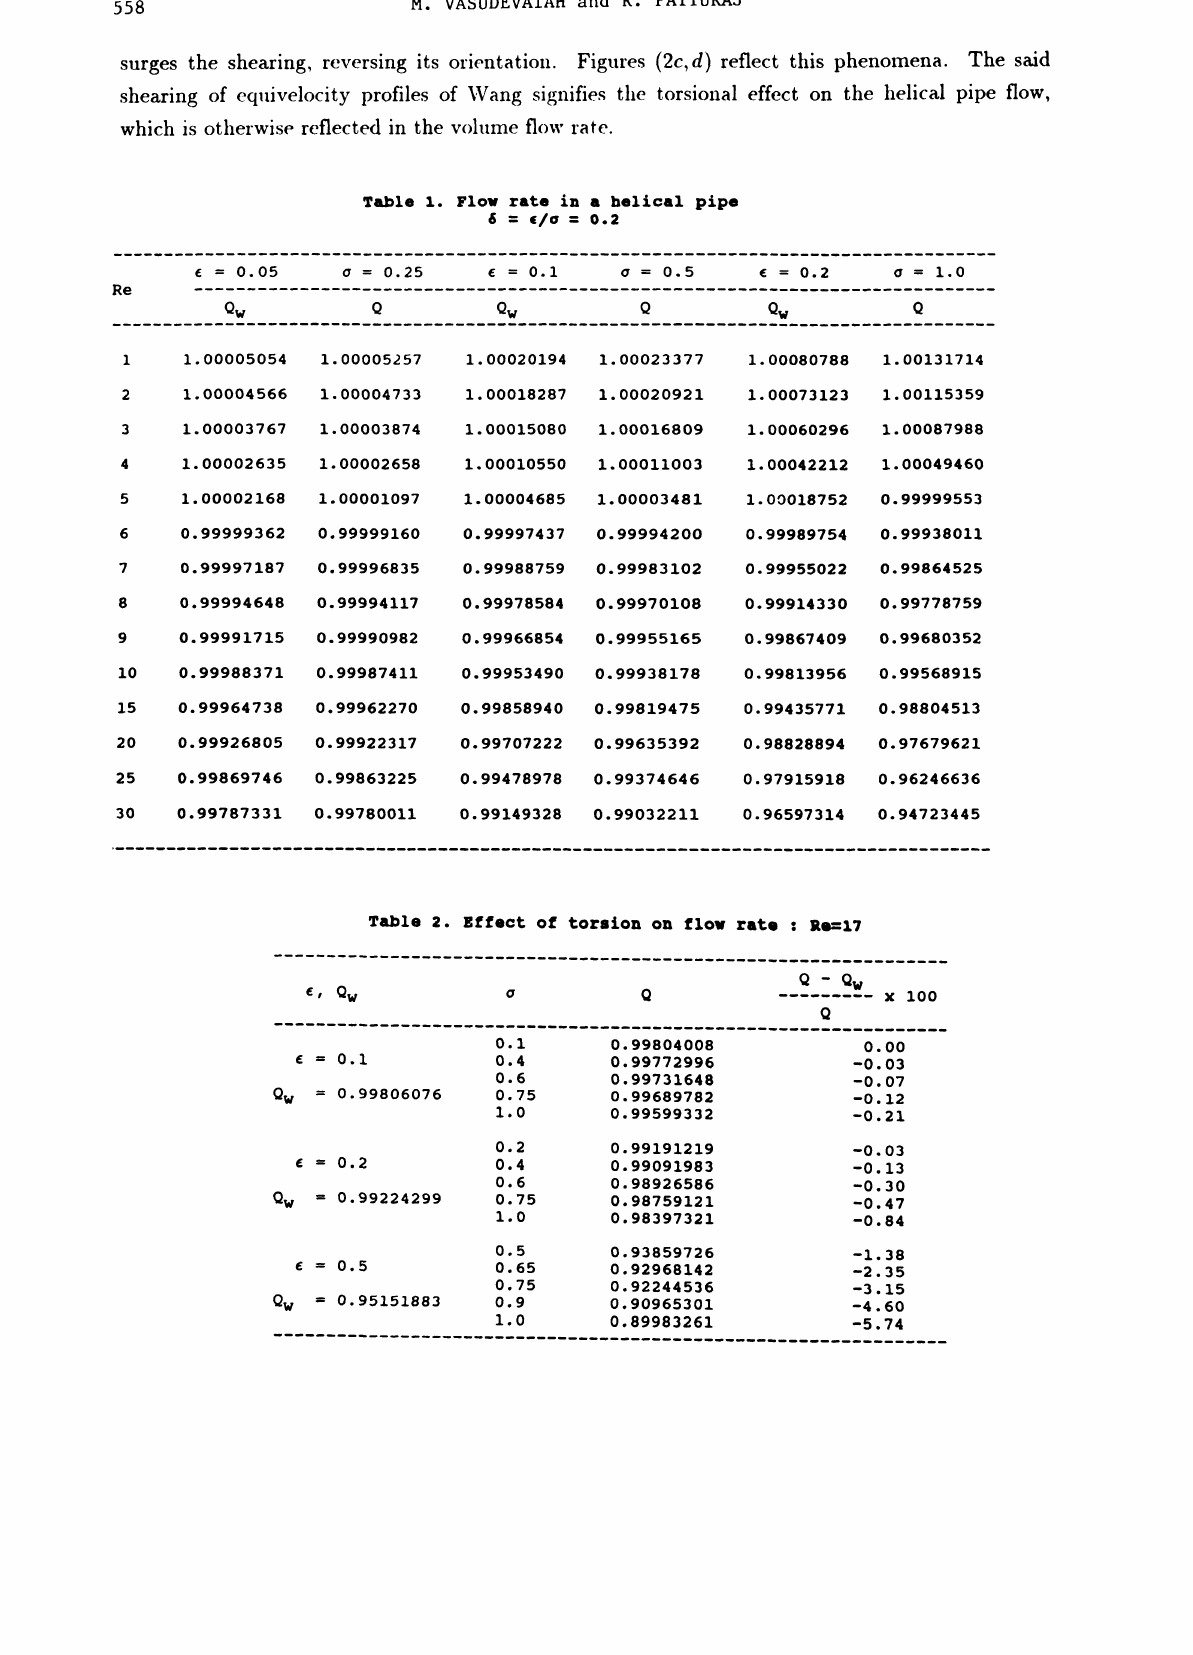
Table 1. Flow rate in a helical pipe E/o